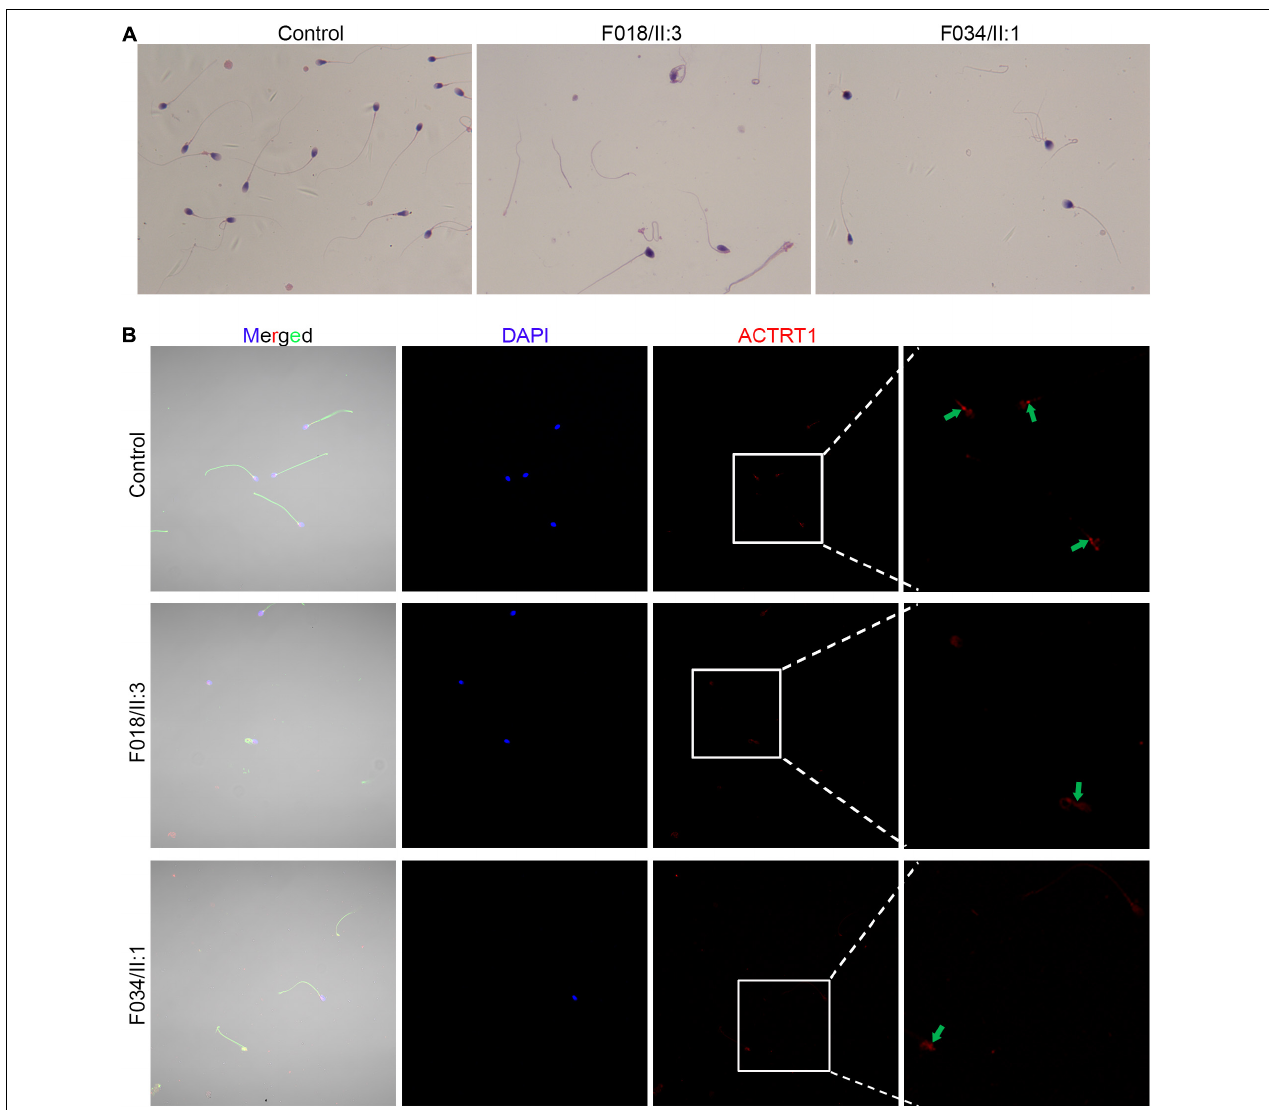
FIGURE 3 | Pathogenic variants of ACTRT1 caused acephalic spermatozoa syndrome. (A) Morphological analysis of spermatozoa from patients with ACTRT1 mutations. Control subjects’ spermatozoa exhibited normal morphology, with the head and tail closely linked, while more than half of the patients’ spermatozoa